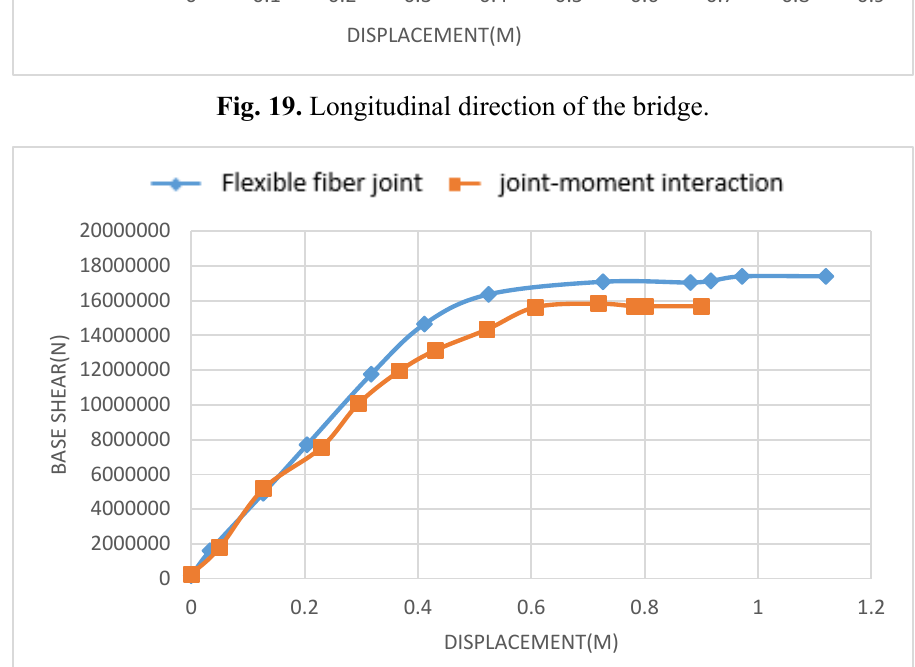
Fig. 20. Longitudinal direction of the